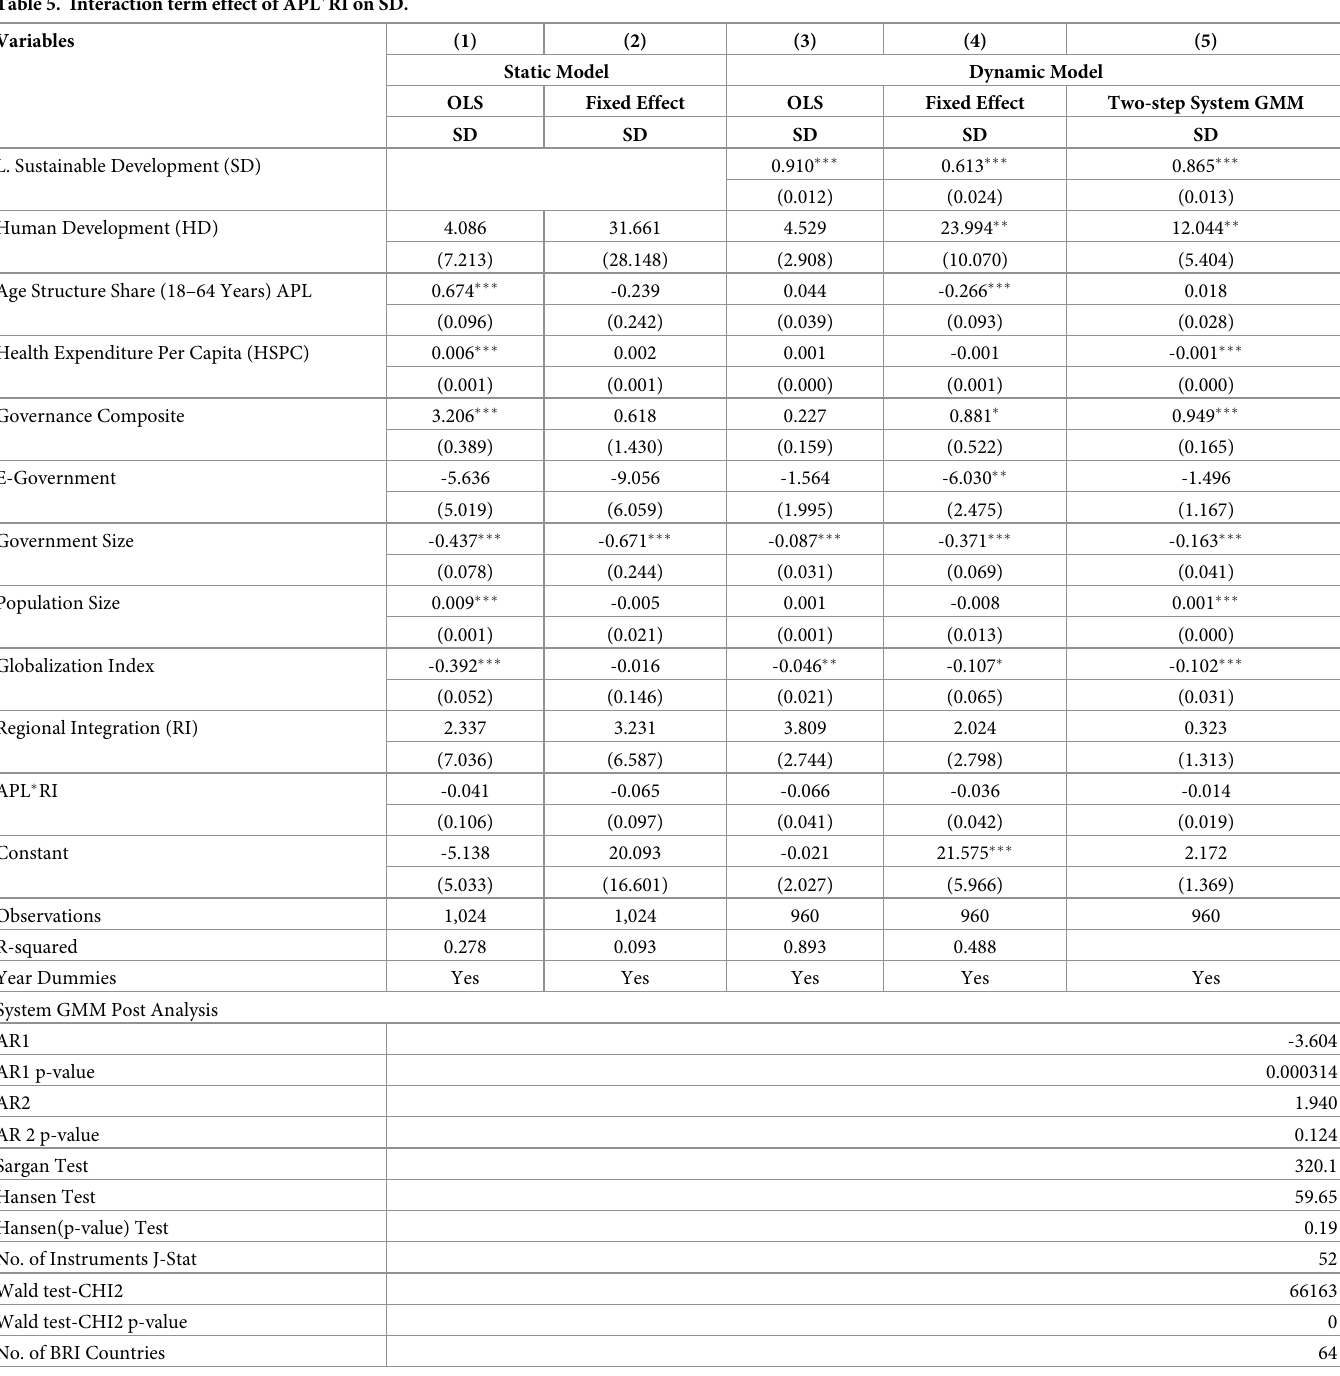
Table 5. Interaction term effect of APL � RI on